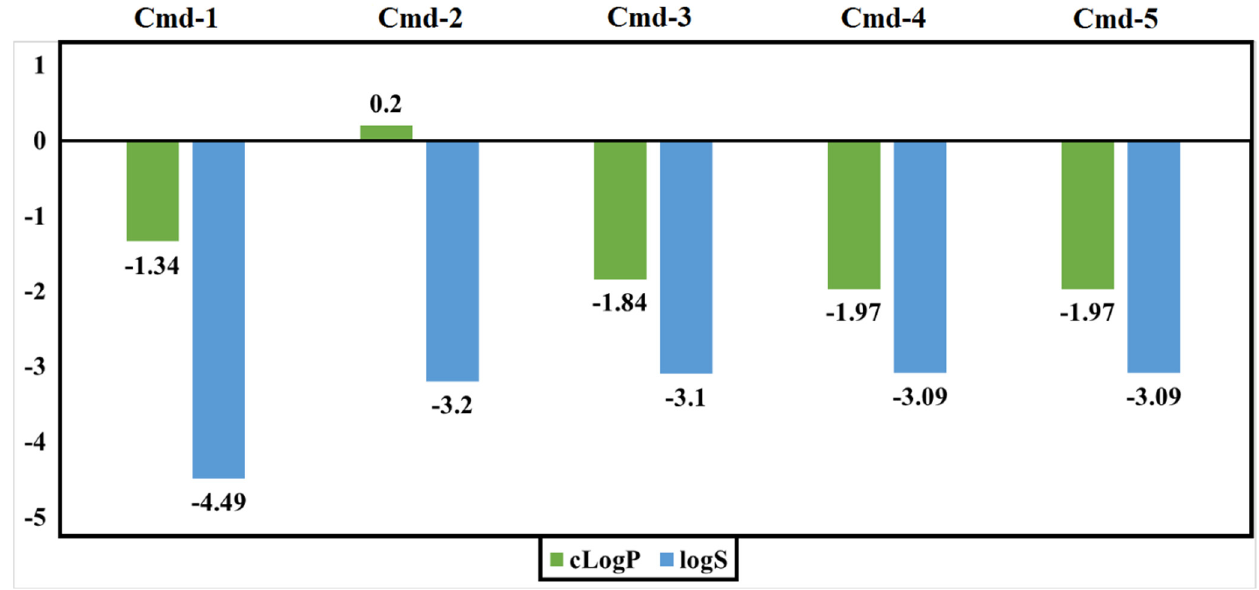
Figure 10. Predicted logS and cLogP values of the best identified